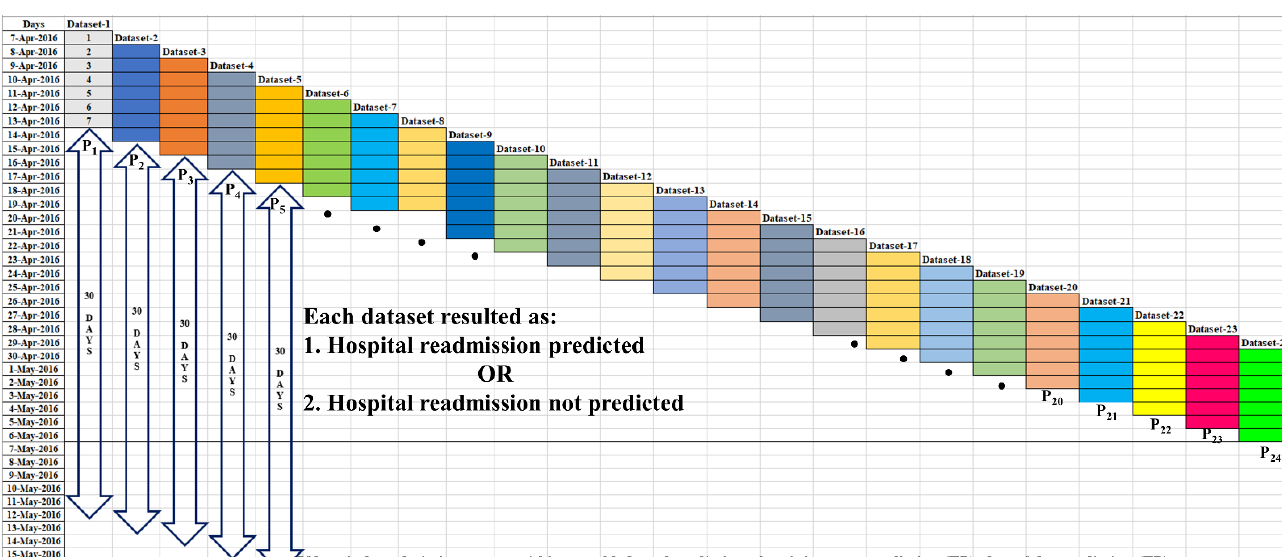
Figure 5. PA dataset method for 30-day hospital readmission prediction.